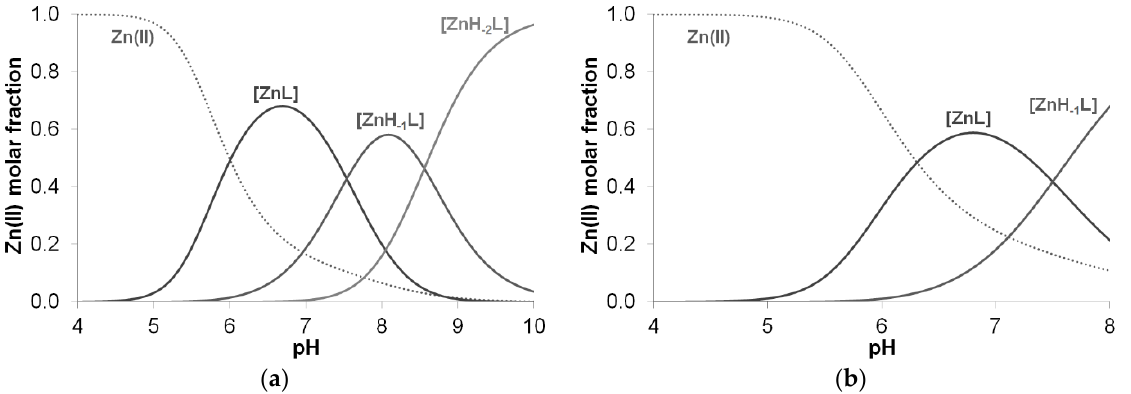
Figure 13. Distribution curves of complexes formed in the equimolar solution of